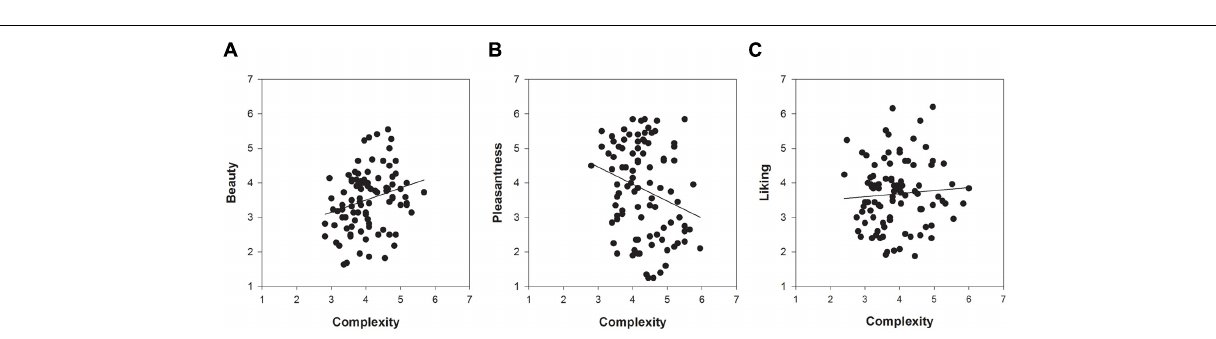
FIGURE 4 | The relationships between complexity and the three measures of hedonic tone for 94 representational paintings: (A) beauty, (B) pleasantness, and (C) liking.